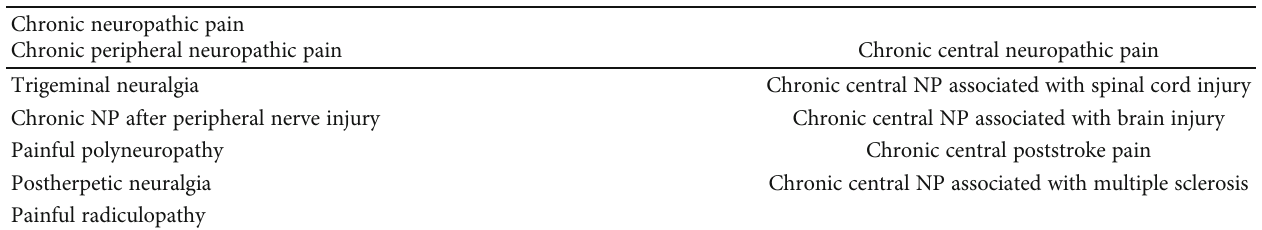
Table 2: The IASP classi fi cation of chronic NP